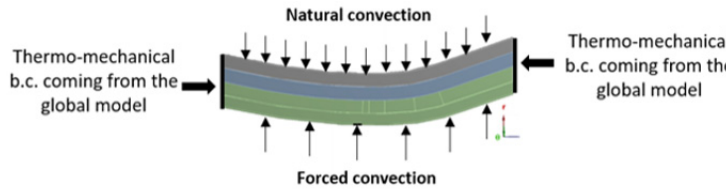
Figure 2. Thermo-mechanical boundary conditions [5].